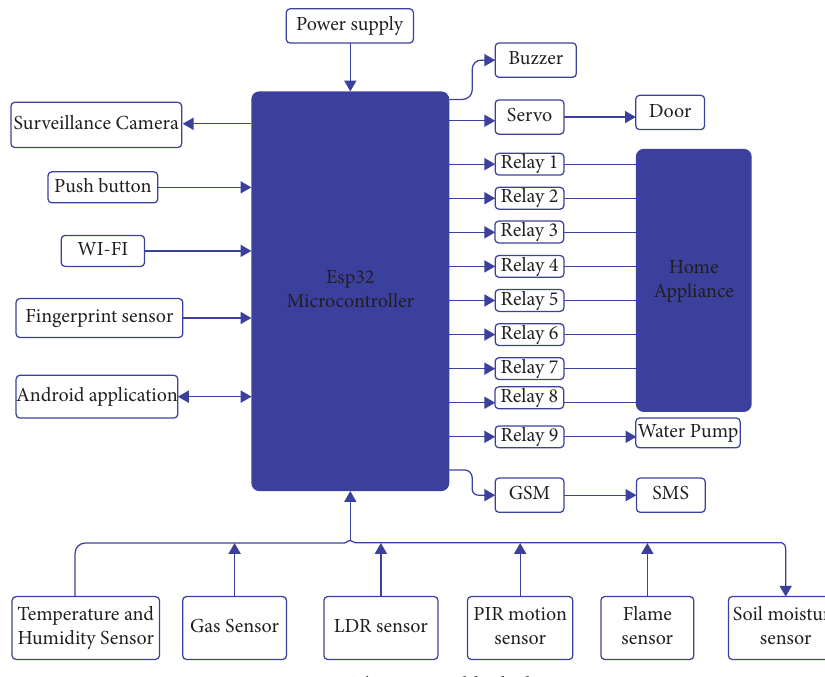
Figure 2: Te system block diagram.